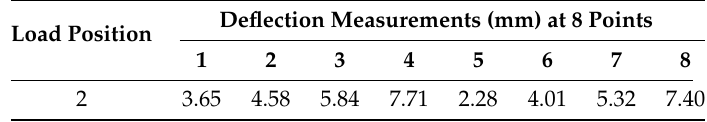
Table A2. New deflection measurements (mm) at 8 points of the UAV wing.